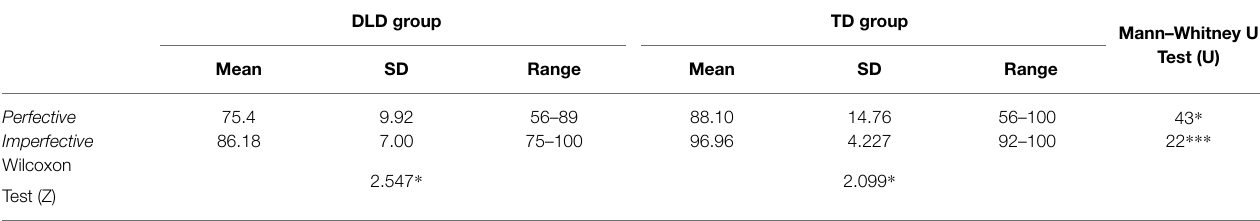
TABLE 3 | Accuracy score (%) for perfective aspect and imperfective